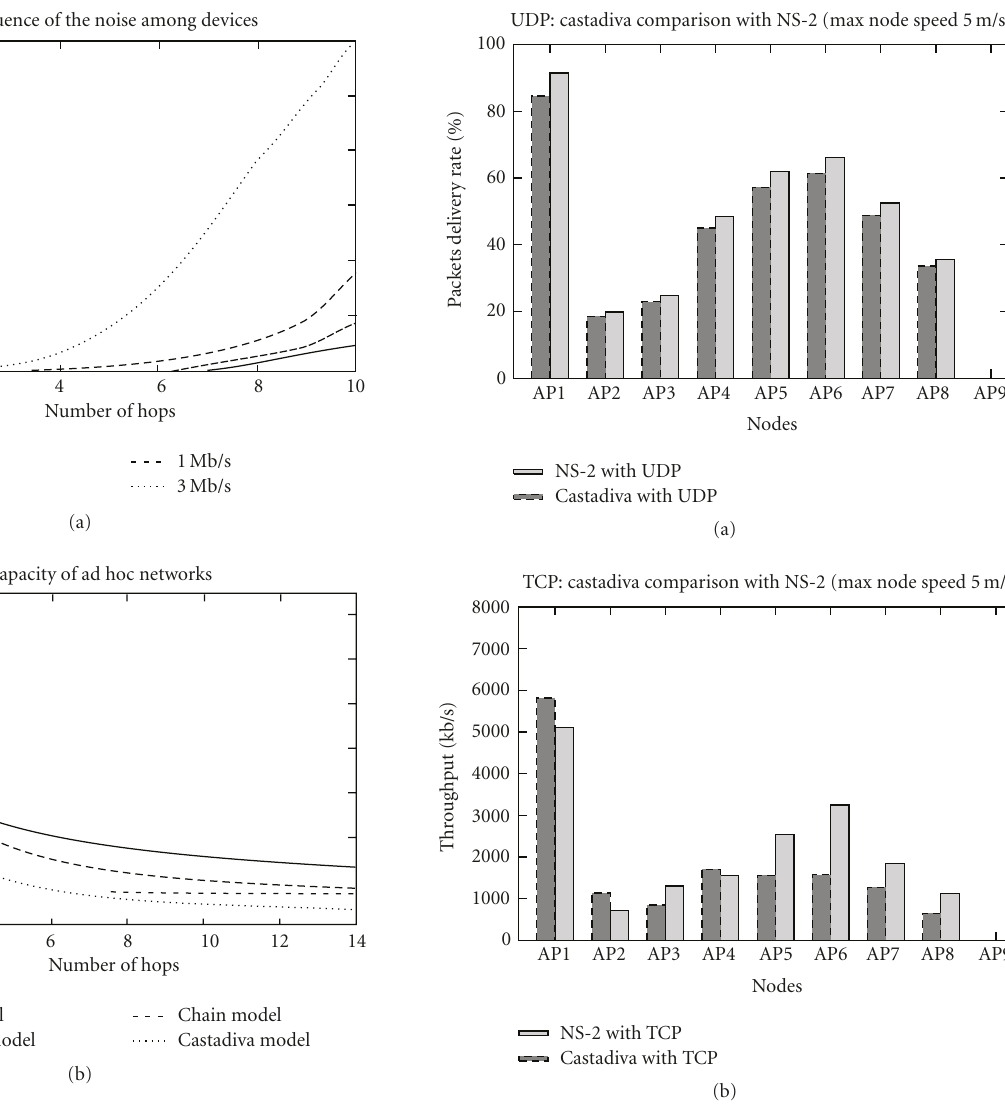
Figure 15: Packet loss due to the proximity of the devices in an emulation (a) and capacity of an ad hoc network compared with Castadiva (b).